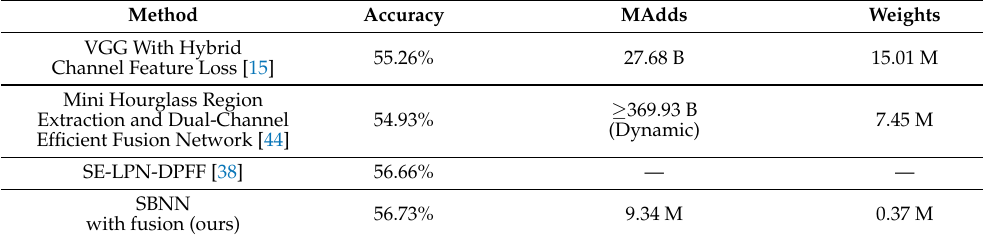
Table 6. The results in the six-categories Dual-Polarization SAR ship classification task.